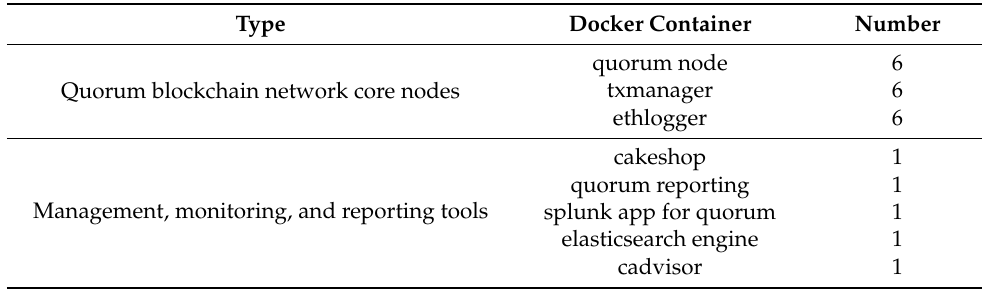
Table 5. Deployed quorum blockchain network